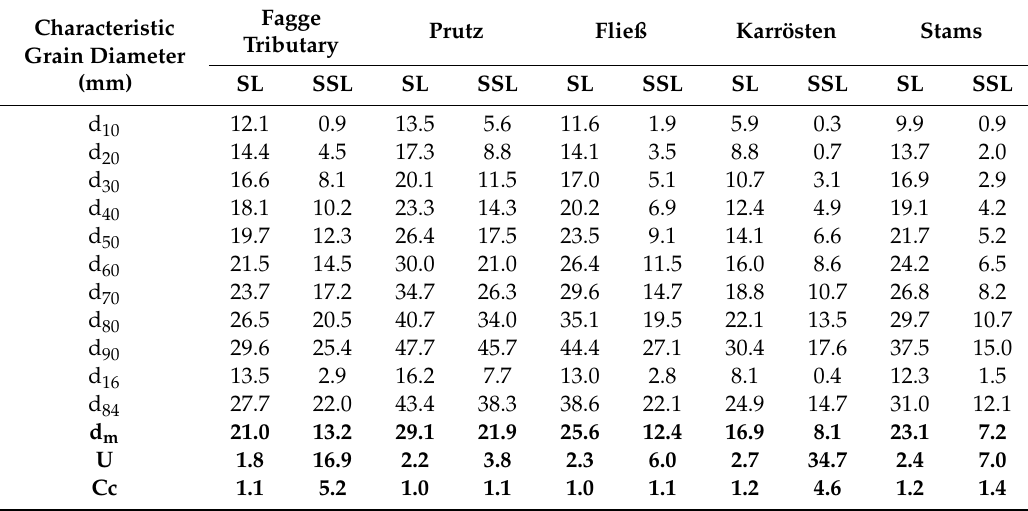
Table 3. Characteristic grain diameters of gravel spawning probes at the surface and the subsurface